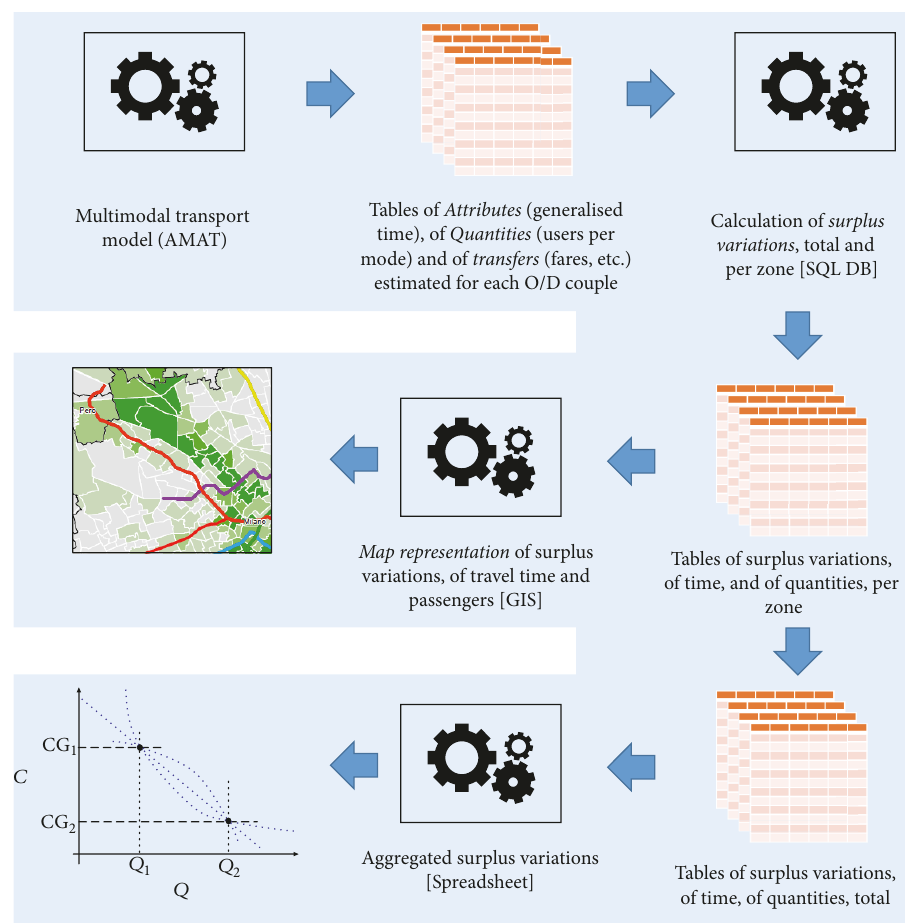
Figure 2: The assessment procedure implemented for the Milan’s Sustainable Urban Mobility Plan